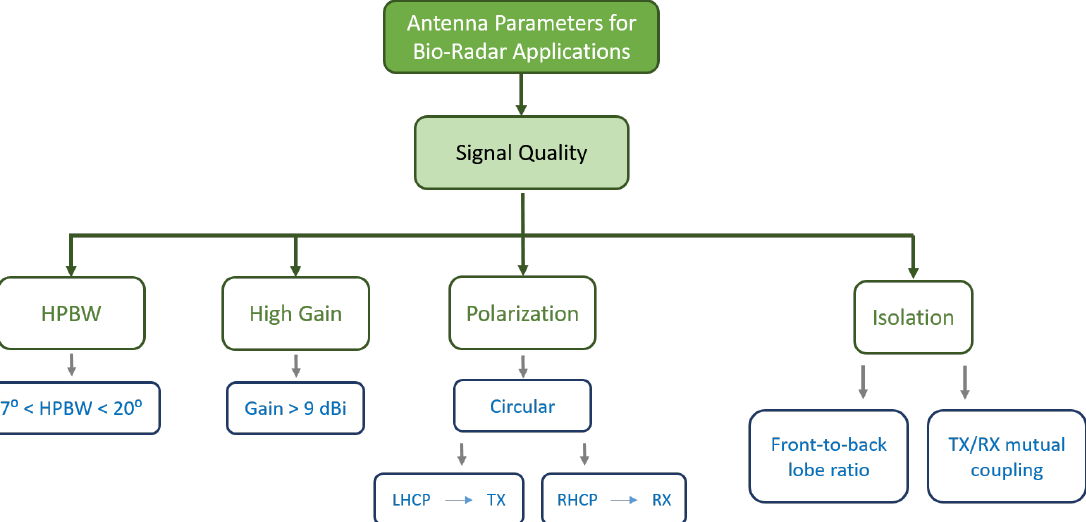
Figure 2. Antenna parameters to improve the acquired signal quality.